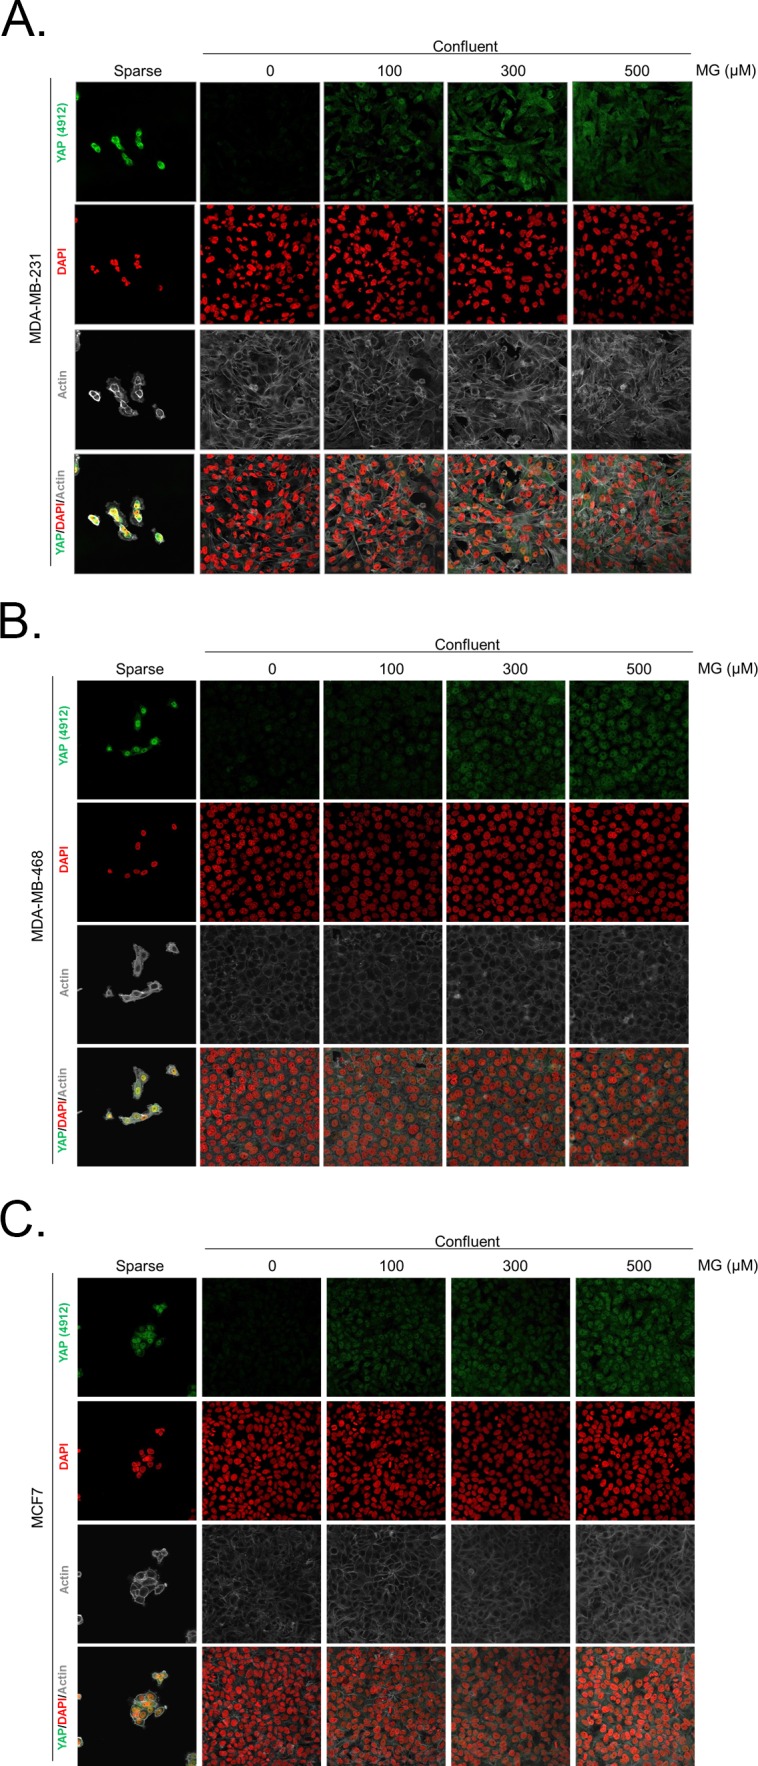
Methylglyoxal induces YAP accumulation in confluent breast cancer cells.(A, B and C) Immunofluorescence (IF) staining shows that YAP (Cell Signaling antibody, 4912) is mainly localized in the nucleus at low cellular density (Sparse) and is weakly detectable at high cellular density (Confluent) in MDA-MB-231, MDA-MB-468 and MCF7 cells. In contrast, cells treated with increasing doses of MG until they reach confluence showed significant YAP cellular accumulation. Magnification 630x. Data are representative of three independent experiments.